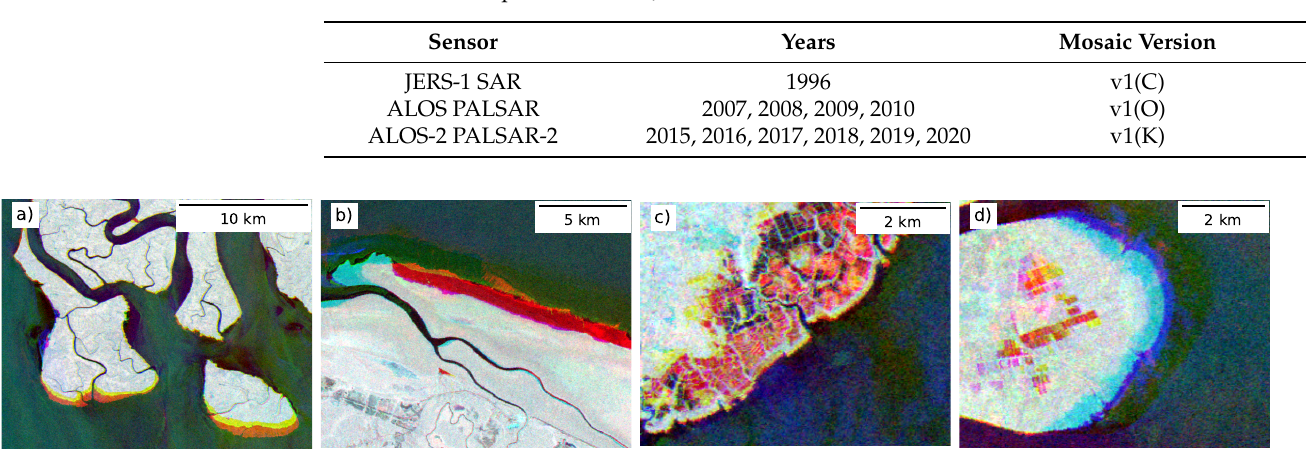
Table 2. The time periods for the JAXA L-band SAR mosaic dataset.